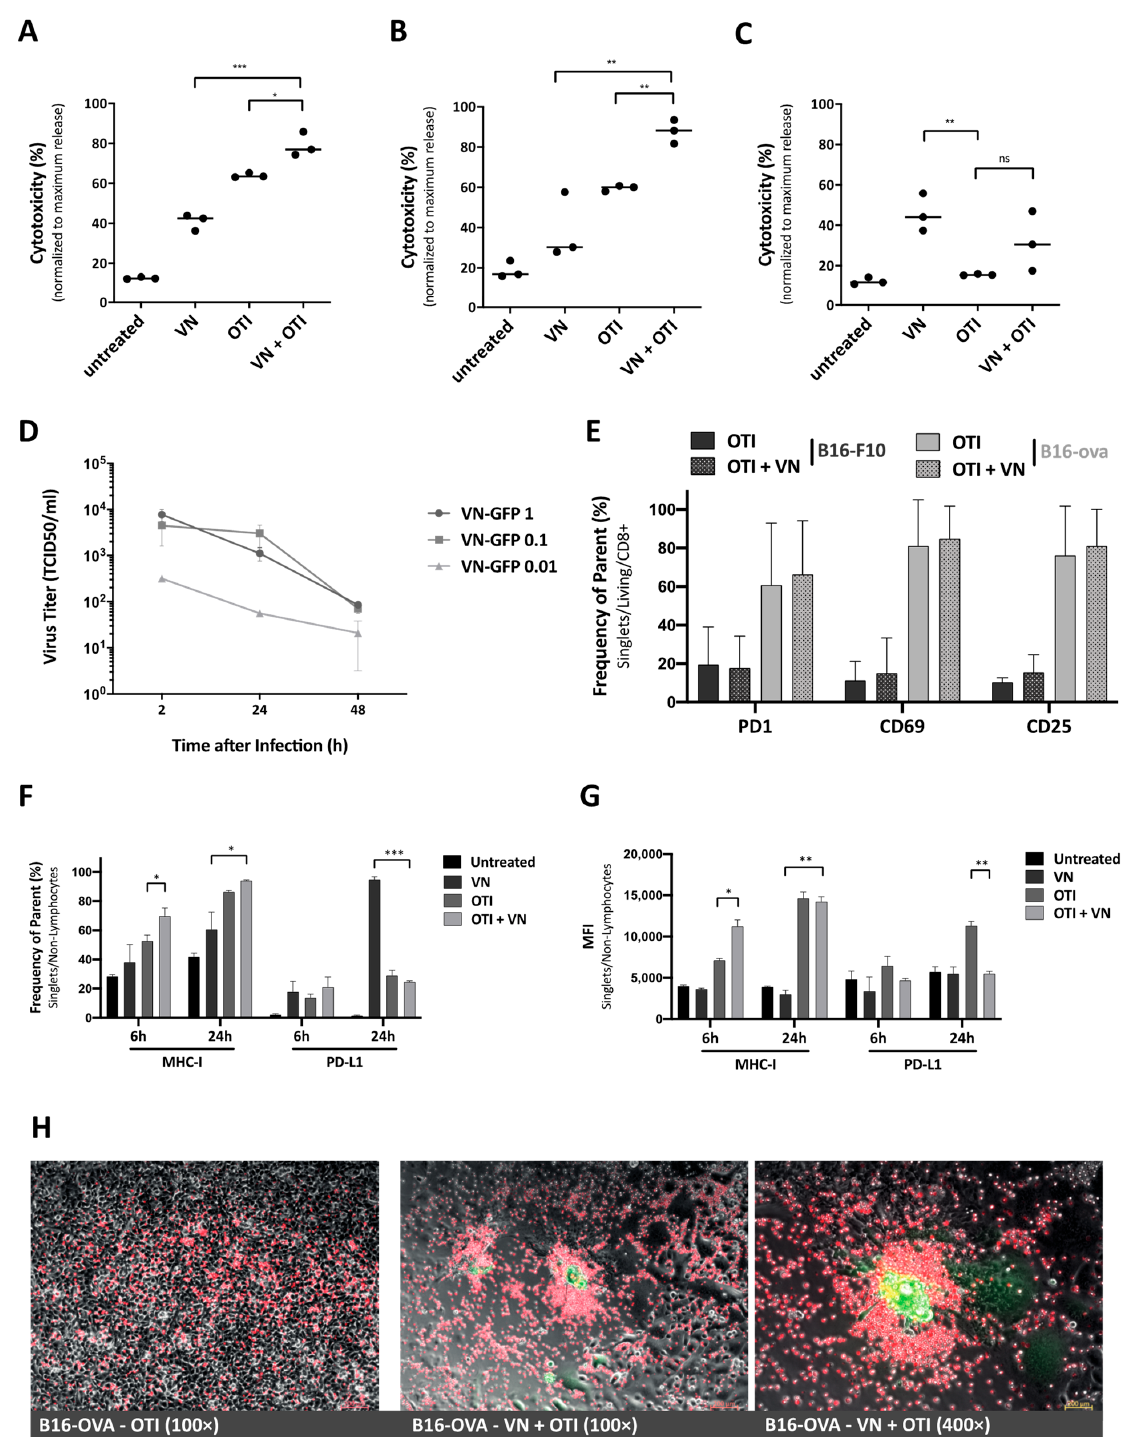
Figure 2. In vitro effects of VSV-NDV and OTI T cell combination therapy. Co-culture experiments were performed by seeding B16 cells and pre-infecting them with VSV-NDV (VN) at MOI 0.1 for 8 h, before adding OTI T cells in a 1:1 effector-to-target ratio. Supernatant samples were collected ( A ) at 8 h after OTI addition to B16-OVA cells or ( B ) 16 h after OTI addition to a 1:1 mixed B16 melanoma (B16-OVA: B16-F10) cell population to determine cytotoxicity by LDH assay. ( C ) Additional co-culture experiments were performed using B16-F10 cells pre-infected with VSV-NDV for 24 h prior to addition of OTI cells and collecting supernatant for LDH assay 16 h later. ( D ) OTI T cells were infected with VSV-NDV at